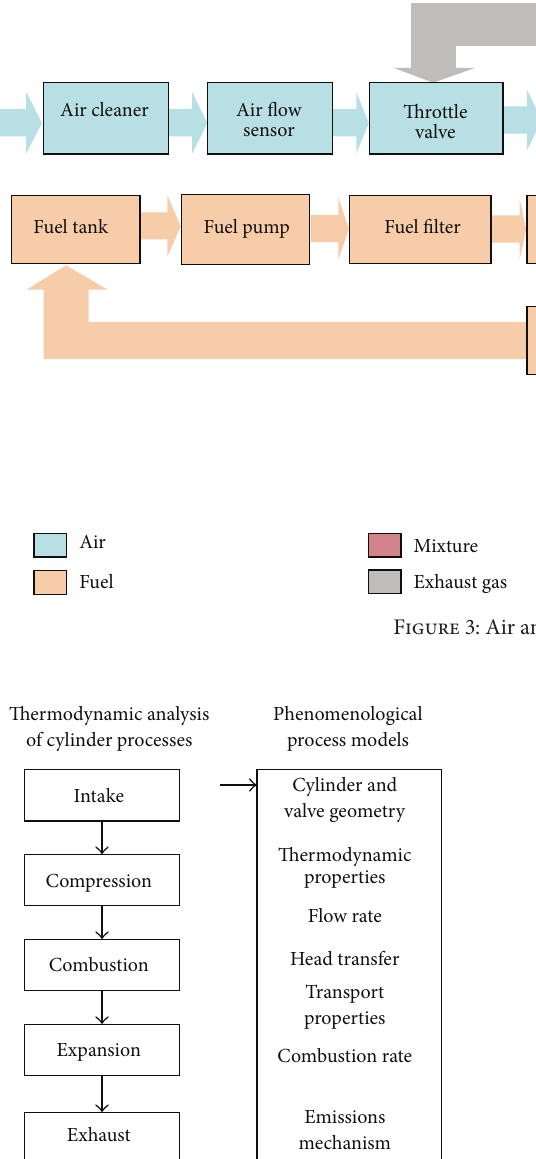
Figure 4: Structure of thermodynamic based simulation of ICE operating